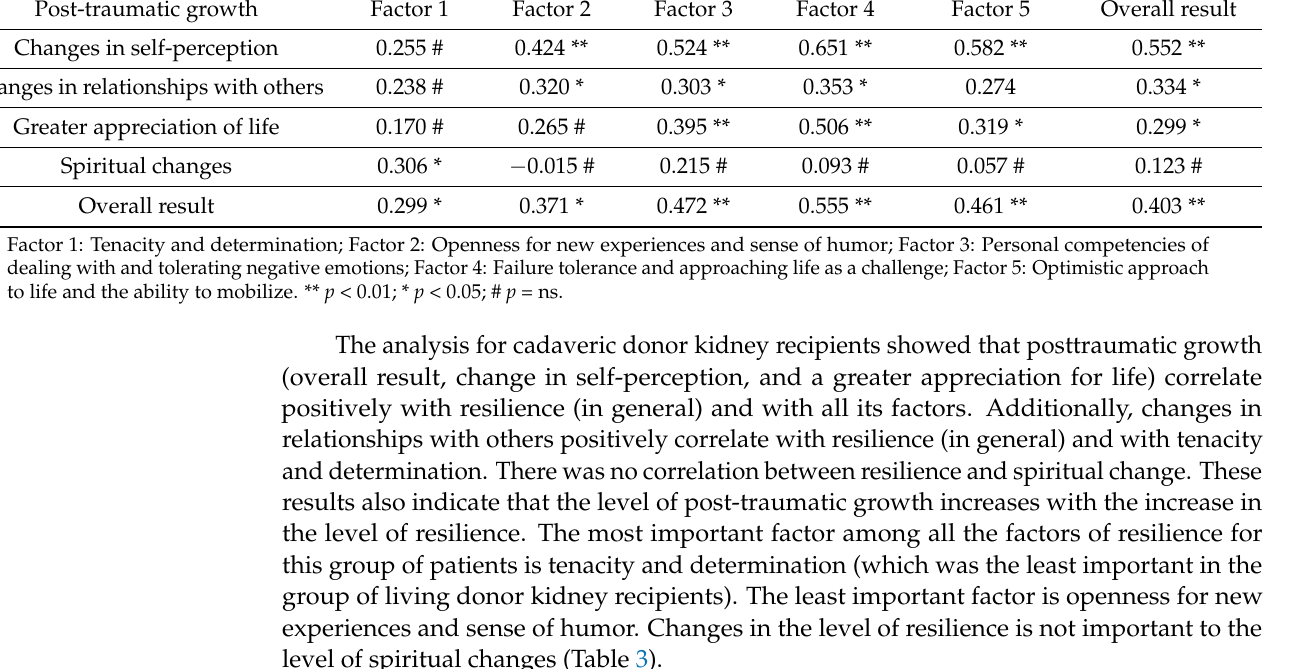
Table 2. Values of the correlation coefficient of resilience with post-traumatic growth in the recipient from the living donors. Resilience